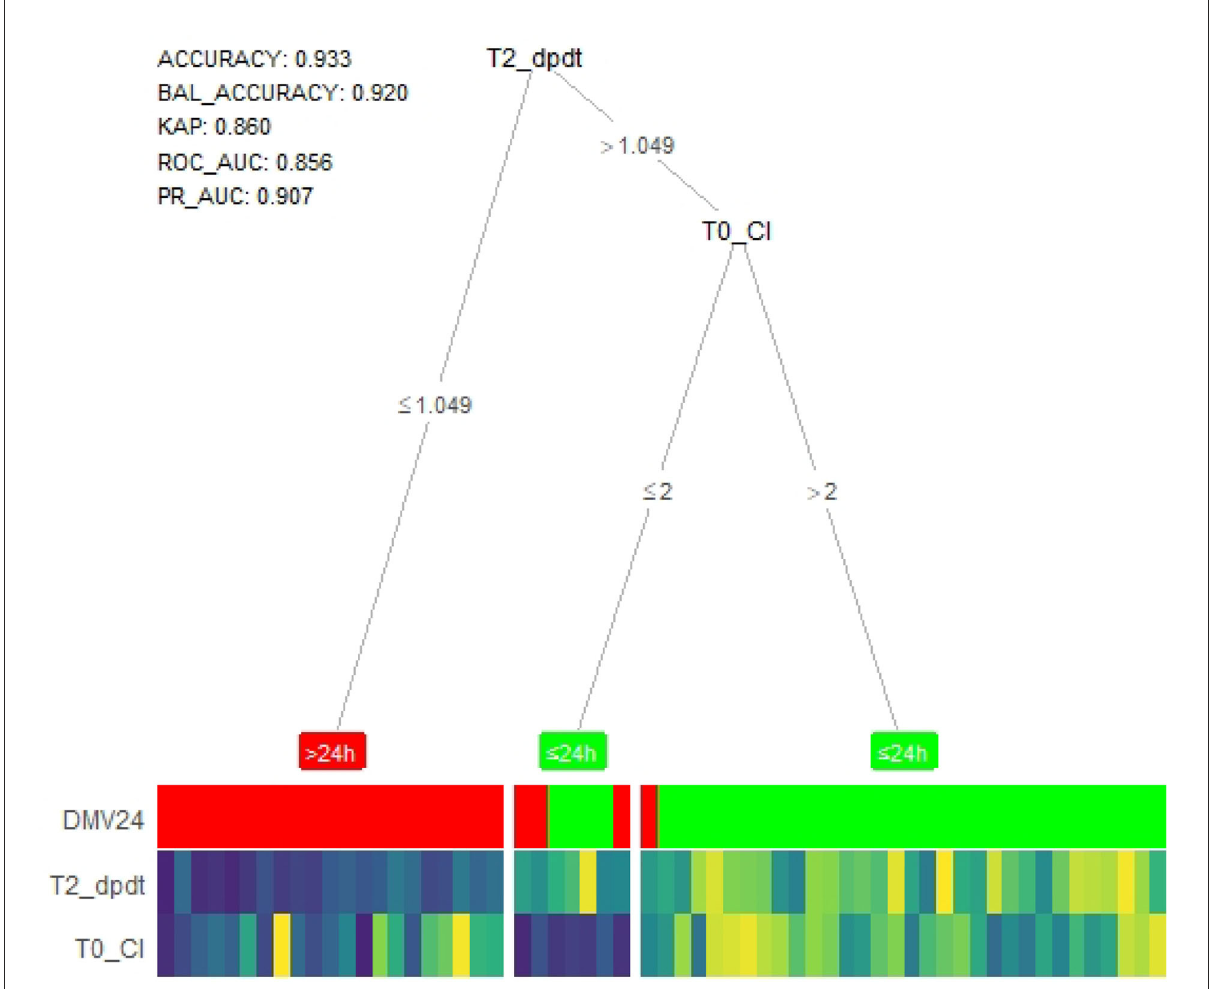
FIGURE4 Tree-heat map of XGBoost machine learning model for prediction. T2_dpdt, dp/dt max (the maximal slope of systolic upstroke) at T2. T0_CI, CI (cardiac index) at T0. DMV, duration of mechanical ventilation. BAL_ACCURACY, balance accuracy, KAP, kappa. ROC_AUC, Under area curve of